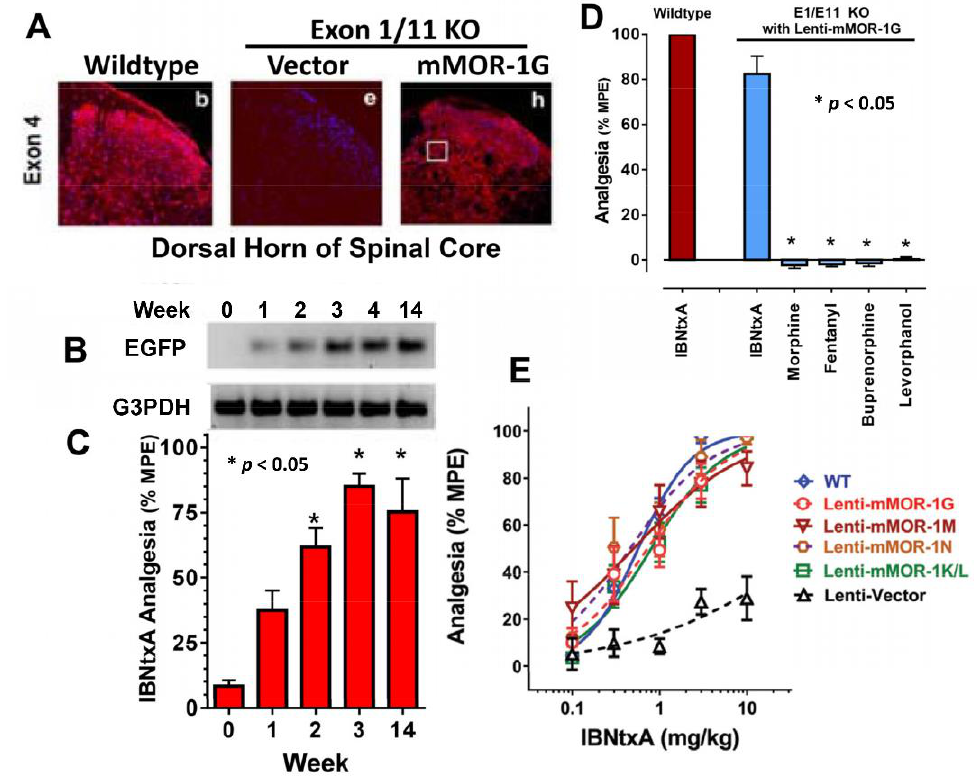
Figure 3. Gain-of-function study using lentivirus expressing the 6TM variants in a double-exon 1/11 KO mouse model. ( A ) Distribution of lentiviral-expressed mMOR-1G in the dorsal horn of the spinal cord with an exon 4 antibody. ( B ) Time course of the spinal EGFP mRNA expression determined by RT-PCR after the lentivirus injection. EGFP was co-expressed in lentivirus as a marker. ( C ) IBNtxA analgesia. ( D ) Opioid analgesia with a single dose of IBNtxA (2.5 mg/kg), morphine (10 mg/kg), fentanyl (0.08 mg/kg), buprenorphine (1 mg/kg), or levorphanol (0.8 mg/kg). ( E ) IBNtxA cumulative dose – response curves. ( A – D ) are adapted from [86] and ( E ) is adapted from [48] .